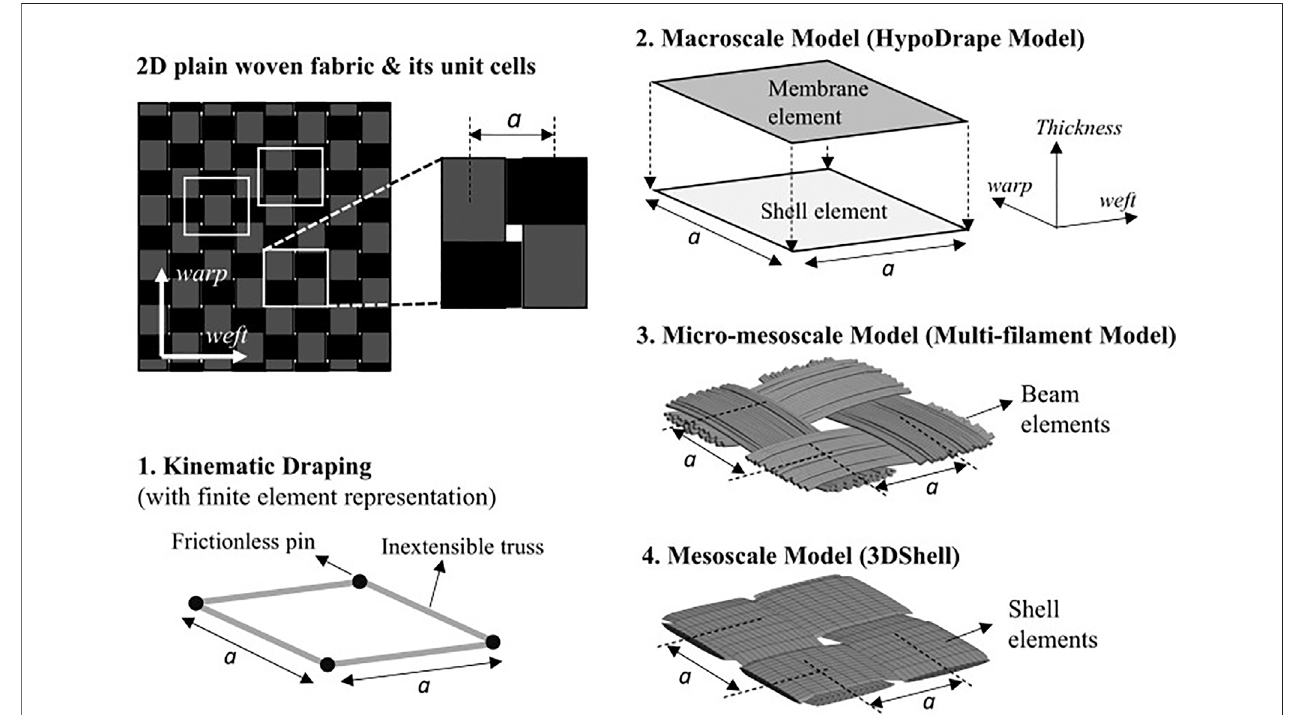
FIGURE 1 | Modelling framework and chracteristics of each modelling approach used for comparison.